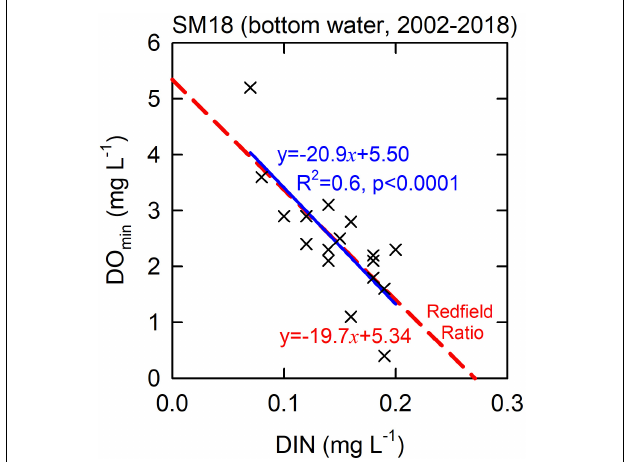
FIGURE 5 | DO min vs. DIN plot at SM18 with linear regression line and equation in blue. The dash line and equation in red show the classic Redfield DO vs. DIN correlation by passing the center of the regression line.